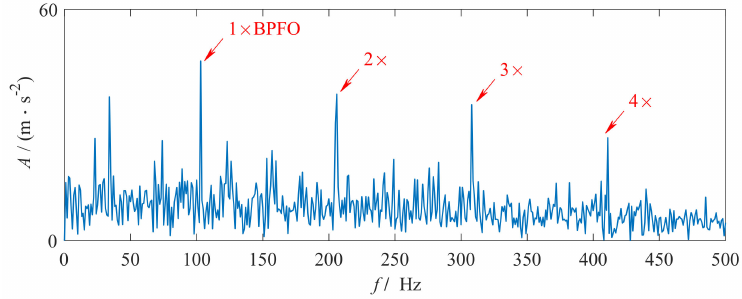
Figure 15. SES of the results by RVMD for the signal from the Curtin